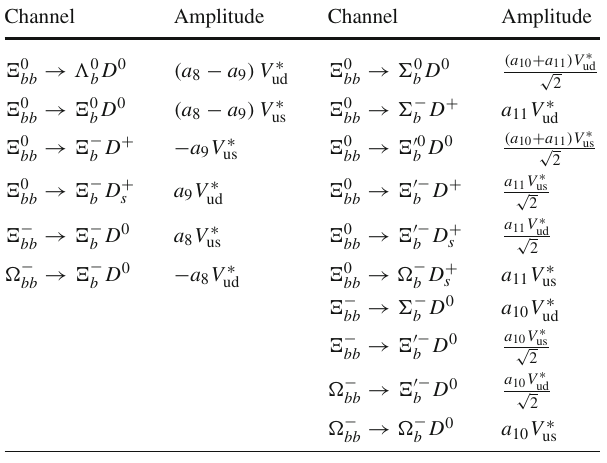
Fig. 9 The Feynman diagrams for (cid:2) bb and (cid:5) bb decays into a bottom baryon and a charmed meson Table 15 Doubly bottom baryons decays into a bqq and a charmed meson